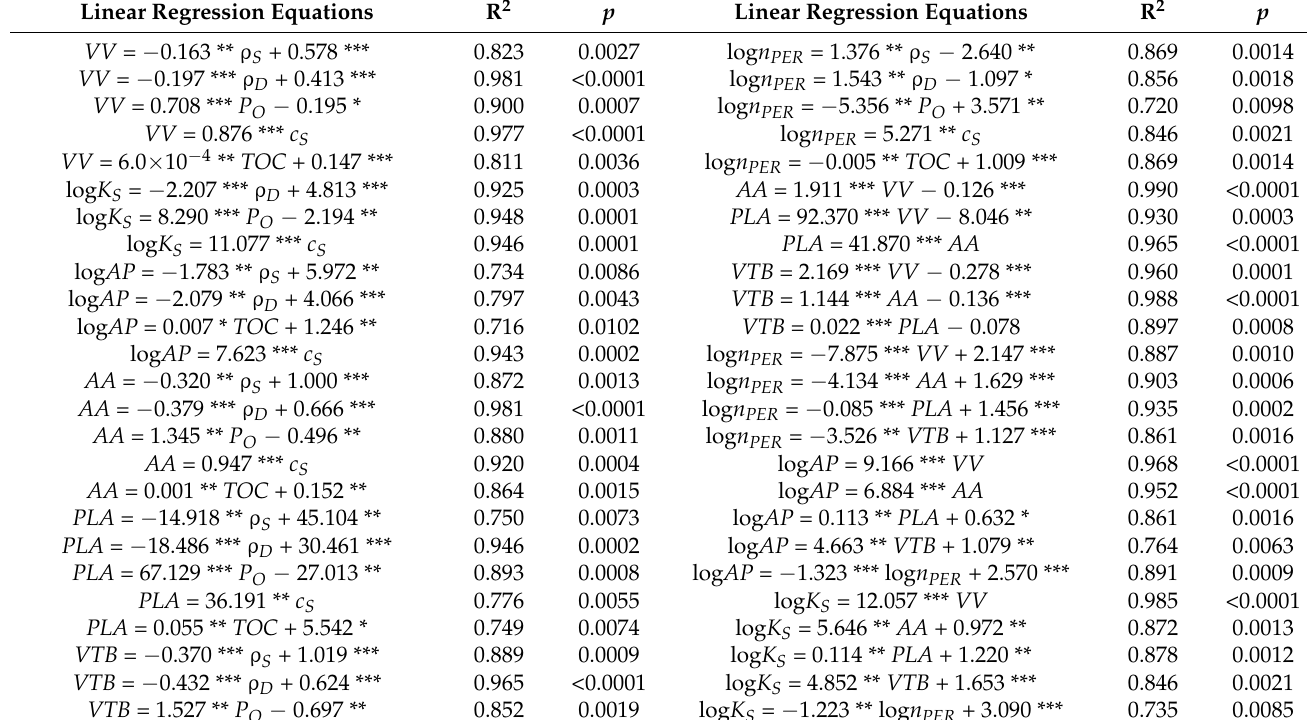
Table 3. Relationships among physicochemical and morphometric parameters. ρ S –particle density; ρ D –bulk density; P O –total porosity; c S –sand; TOC –total organic carbon; VV –air capacity at − 15 kPa; AP –air permeability at − 15 kPa; K S – hydraulic conductivity; AA –macroporosity by image analysis; PLA –relative length of pore path; n PER –percolation number; VTB –relative volume of pores overlapping the top and bottom edge of the image. Linear Regression